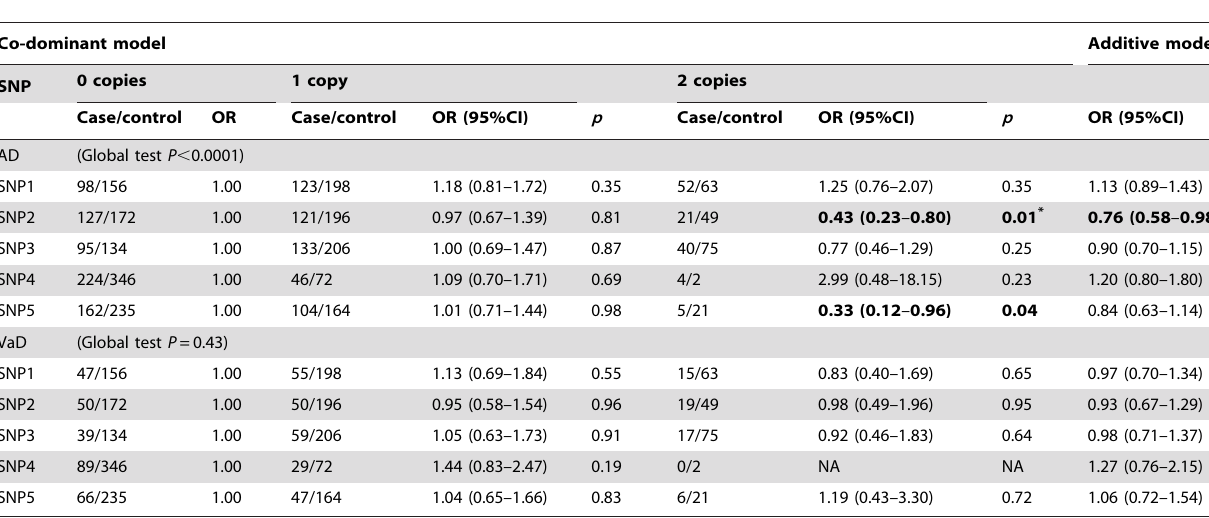
Table 3. NINJ2 SNP analysis by genotype for dementia patients and controls.